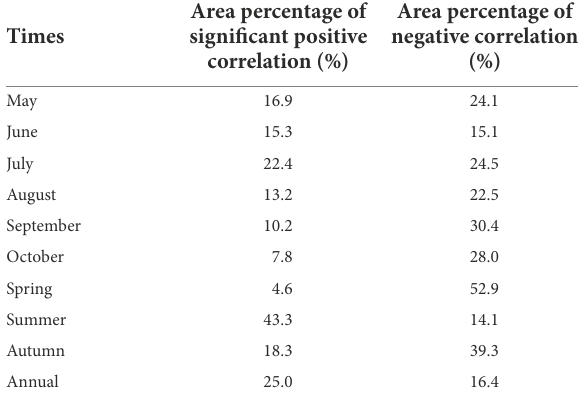
TABLE 1 The spatial area percentage of correlation between NDVI and SPEI same period